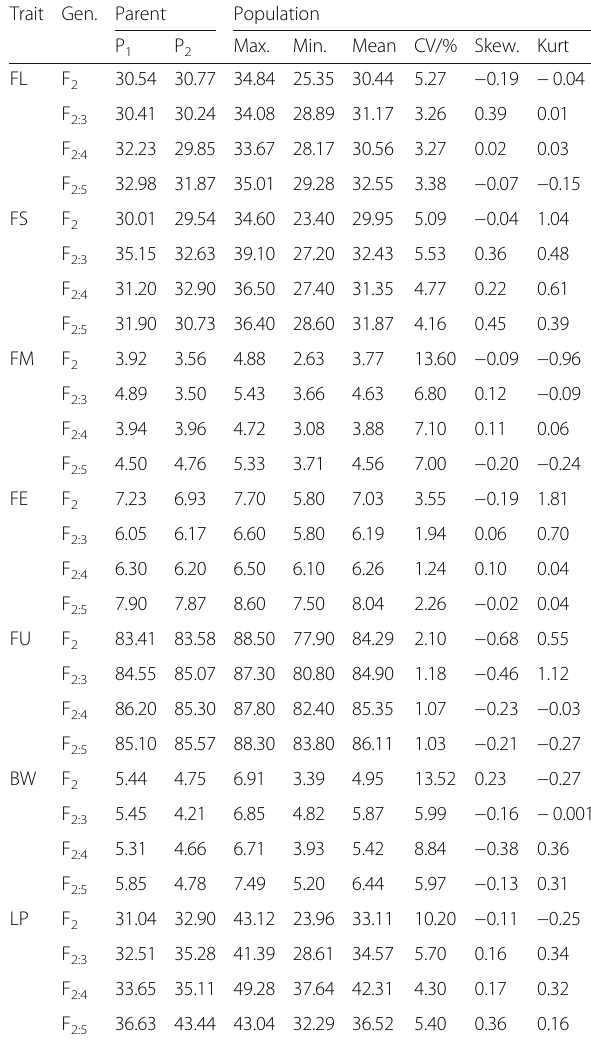
Table 1 The phenotypic analysis of fiber quality and yield- related traits in different generations Trait Gen. Parent Population Max.